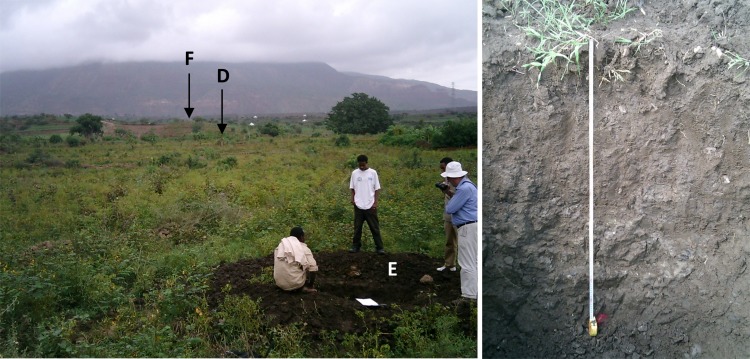
Location of soil profile pit E in Agbe, Abergelle lowlands (left) and profile E (Chromic Vertisol, right). At the back, the Adigrat sandstone cliff is visible; arrows indicate the approximate locations of soil profiles D and F.